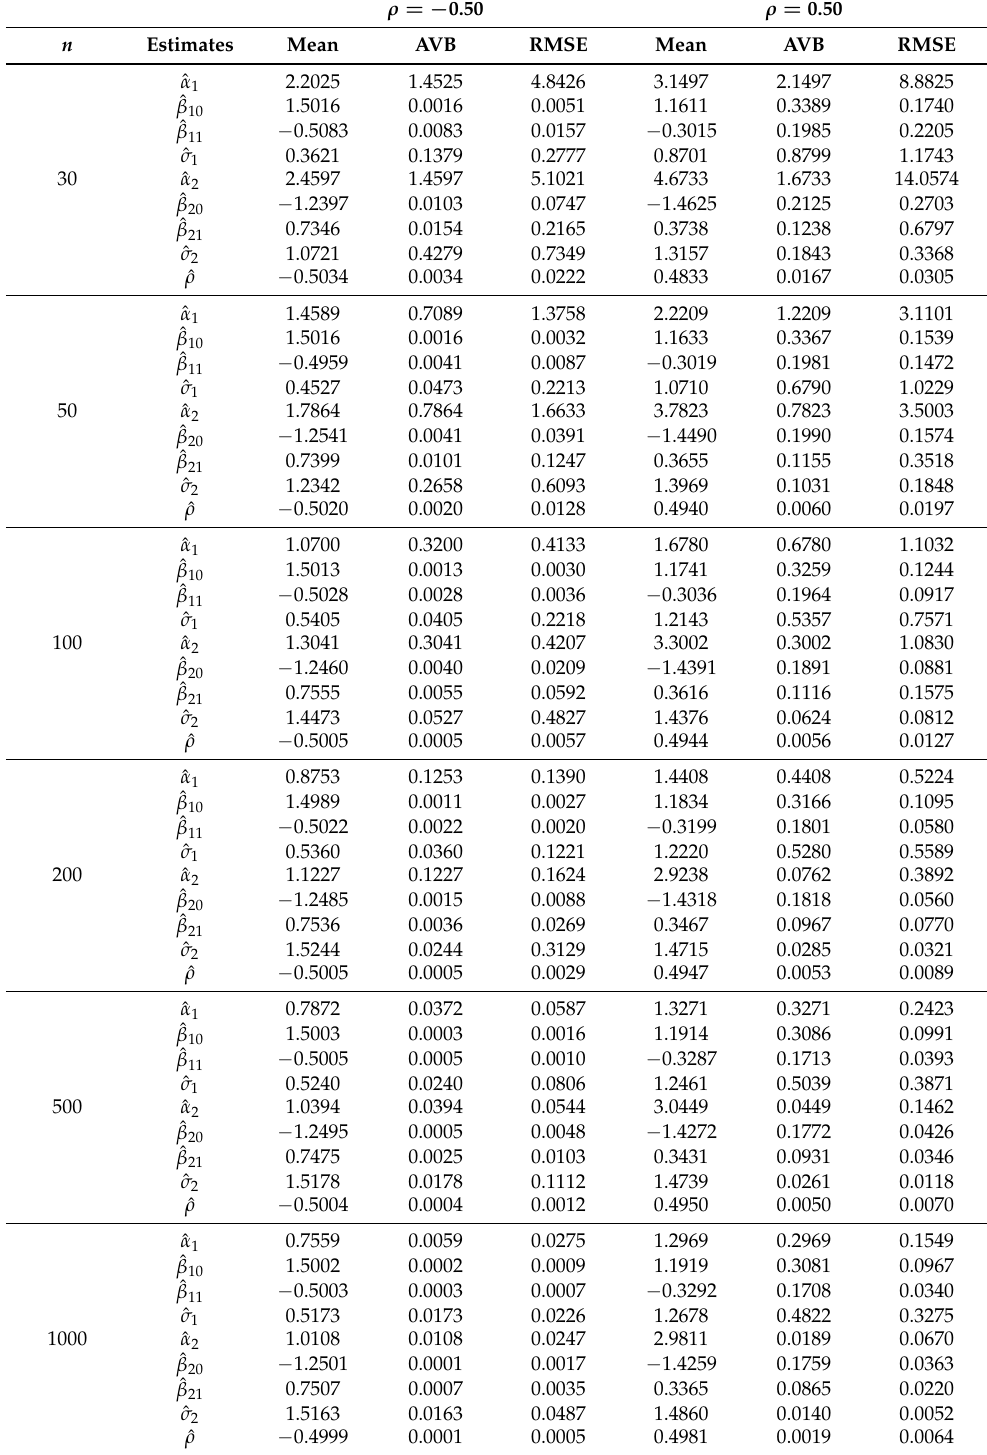
Table A3. Asymptotic behavior of the MLE for the BVSHN regression model with parameter